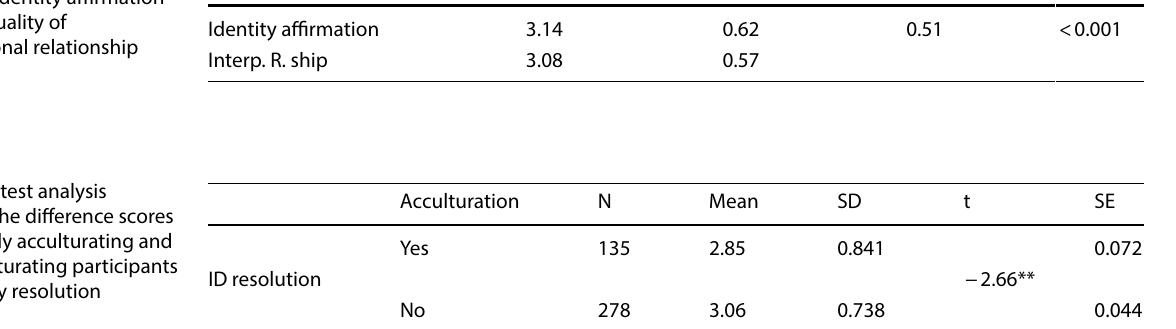
Table 5 The relationship between identity affirmation and the quality of interpersonal relationship